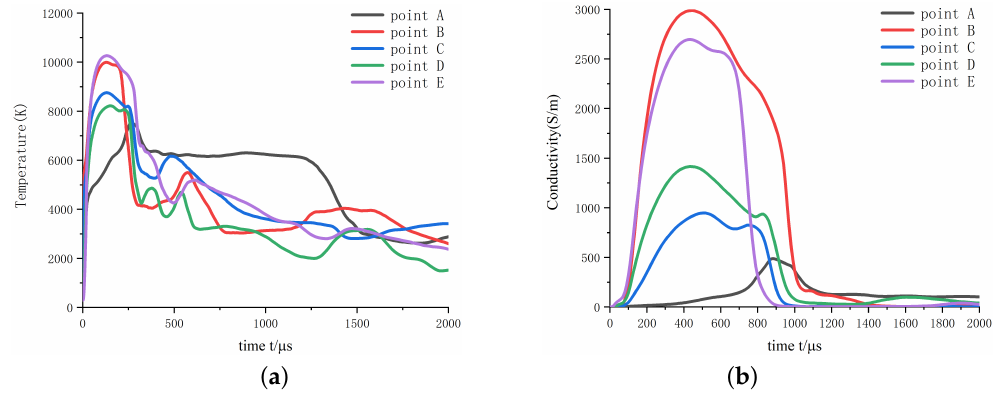
Figure 9. Observation point temperature and conductivity change curve: ( a ) Observation point temperature change curve. ( b ) Observation point temperature change